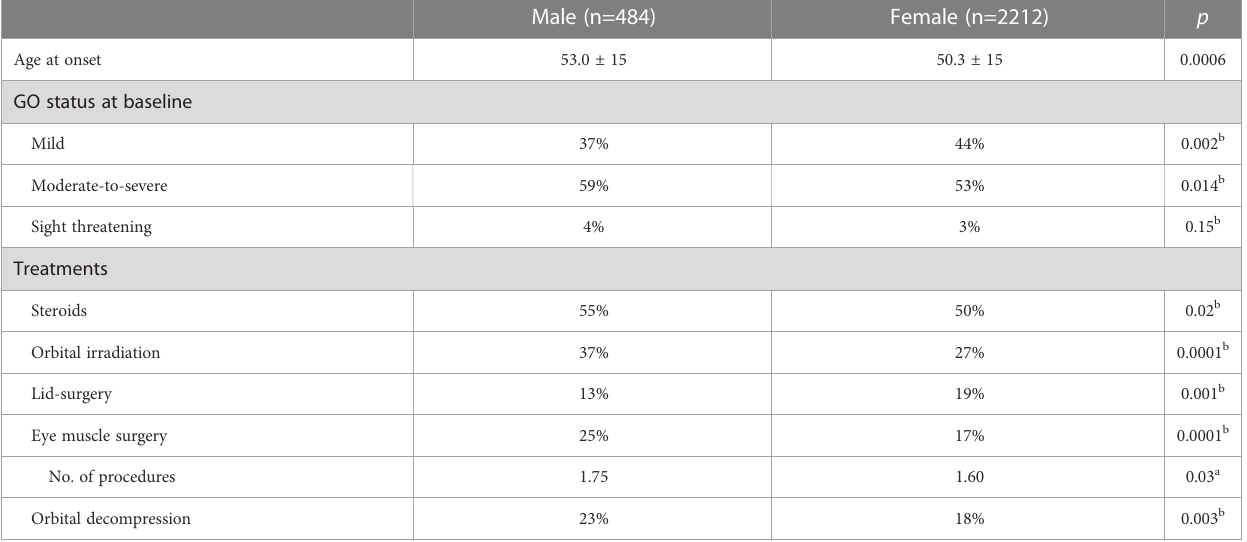
TABLE 3 Subgroup analysis of non-smoking male vs.